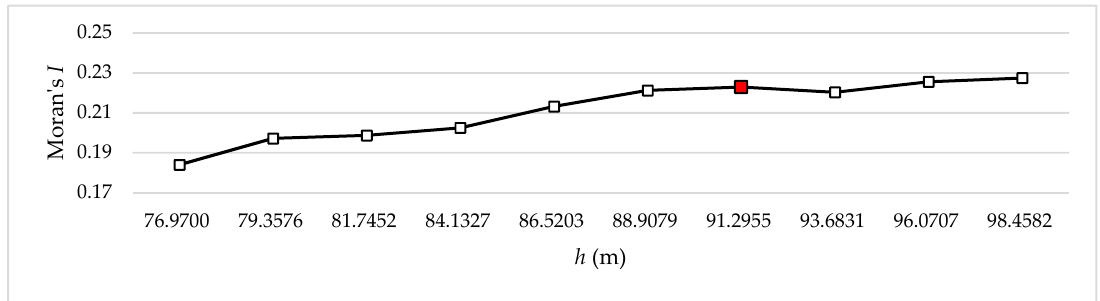
Figure 6. Changes of Moran’s I according to the cluster size at level 11.